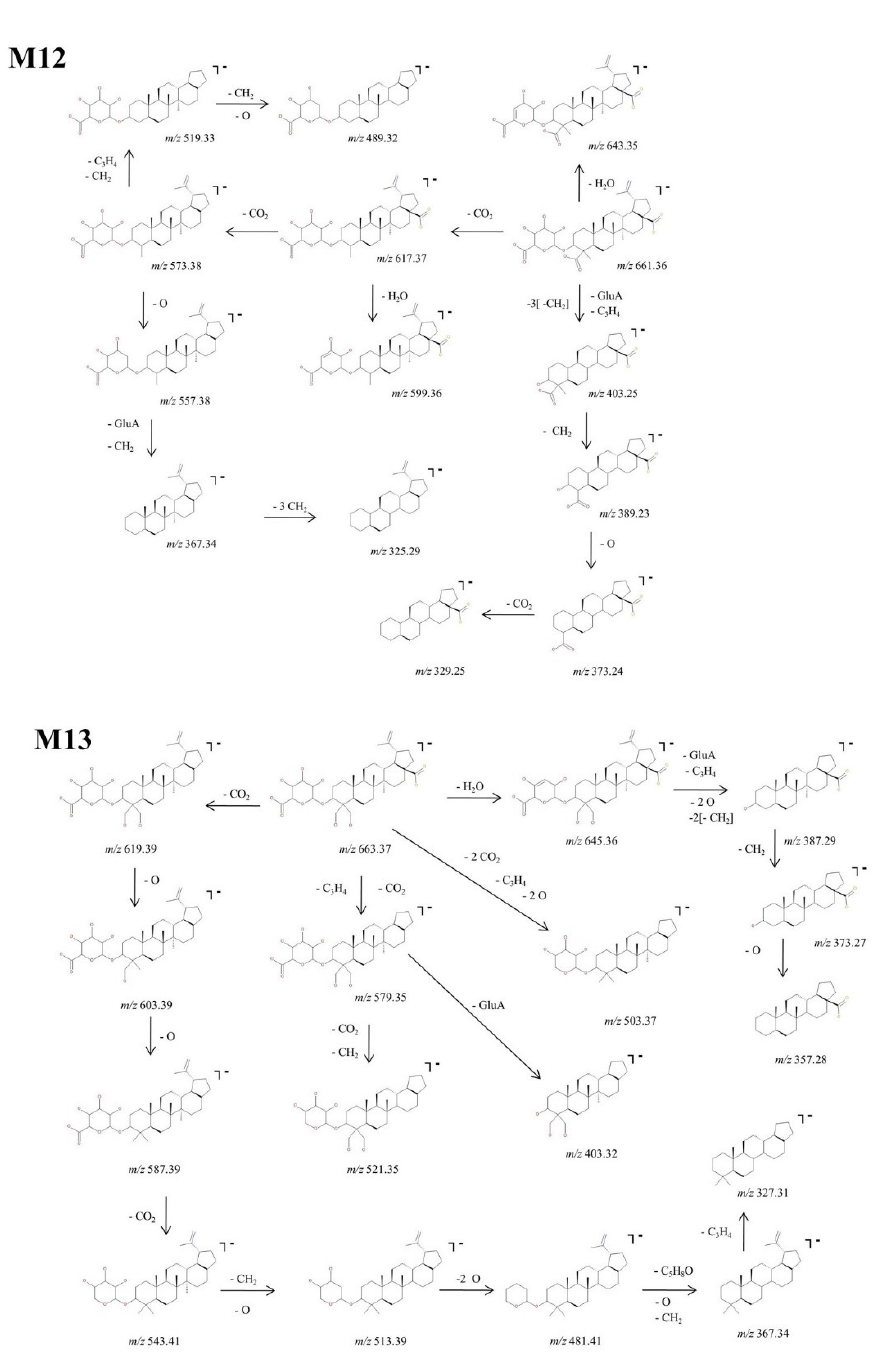
Figure 10. Proposed fragmentation pathway for phase II metabolites: M12 – M13.